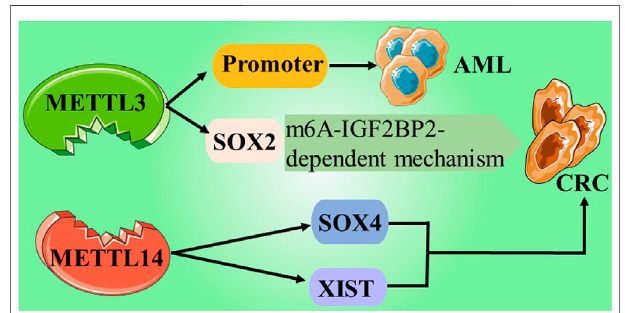
FIGURE 2 | Give examples of the role and mechanisms involved writers in cancers.